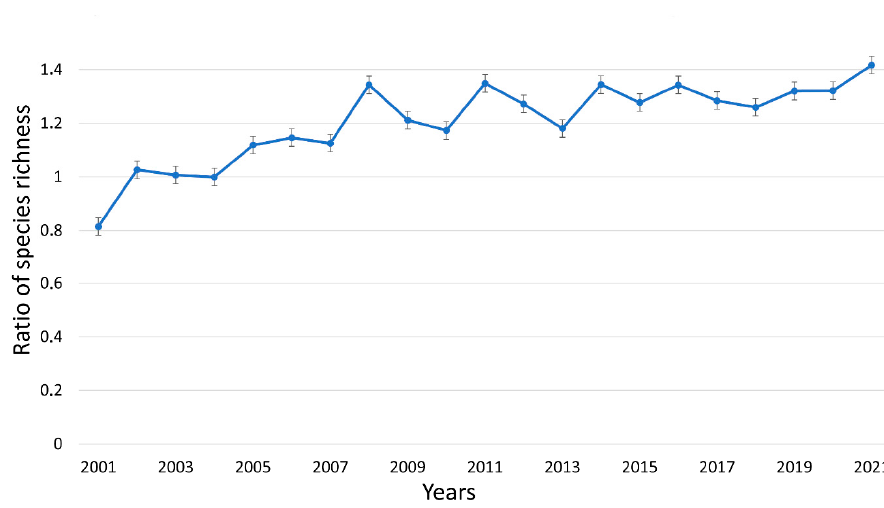
Figure 5. Ratio of species richness between mown and control plots with standard errors over the study period.